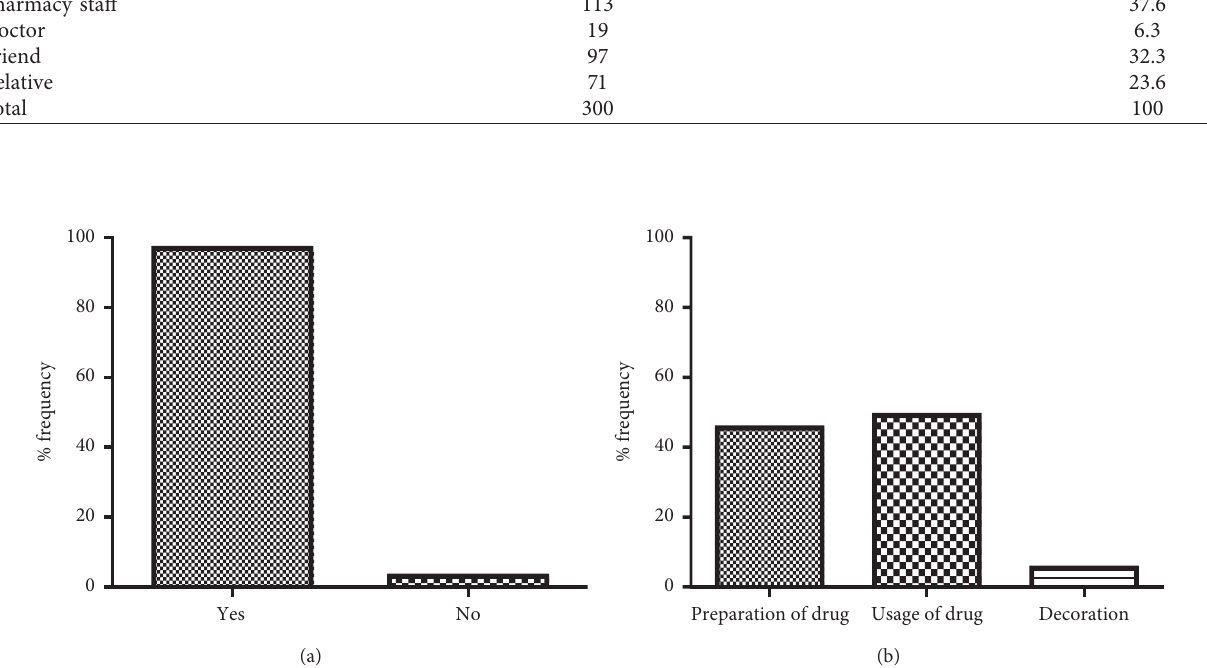
Figure 1: (a) Provision of the drug leaflet on medication to respondents. (b) Perception of respondents about the purpose of PI